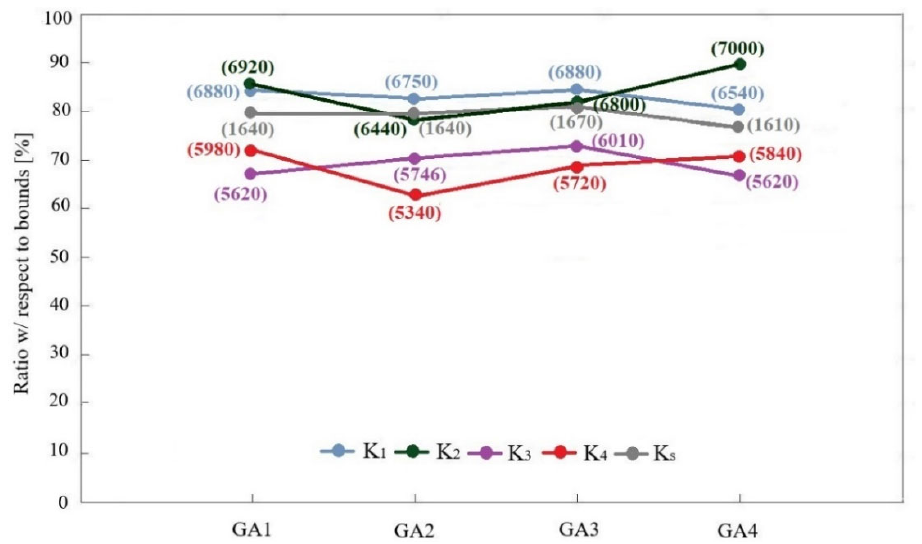
Figure 16. Values of the optimal parameters for the optimization runs GA1–GA4 for the loaded vehicle numerical model.